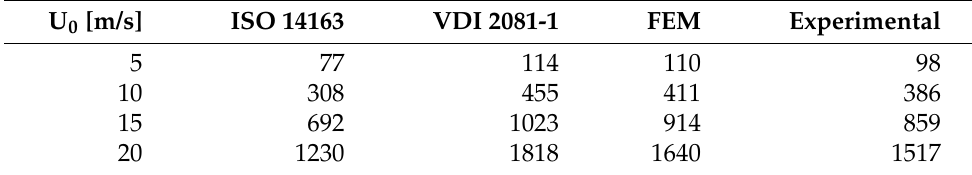
Table 4. Pressure loss (in Pascals) obtained with ISO 14163, VDI 2081-1, FEM and experimental measurements for the system of splitters with semihexadecagonal